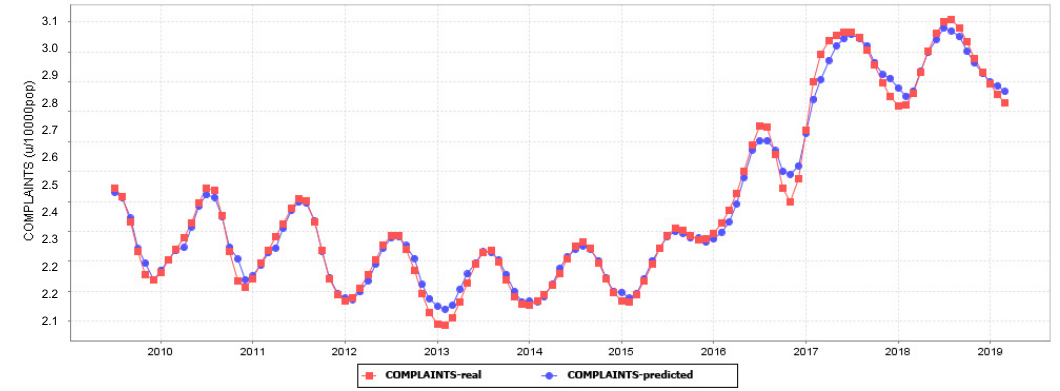
Figure 1. Training phase with RF algorithm of the subset MOES-RF for GBV complaints data series.